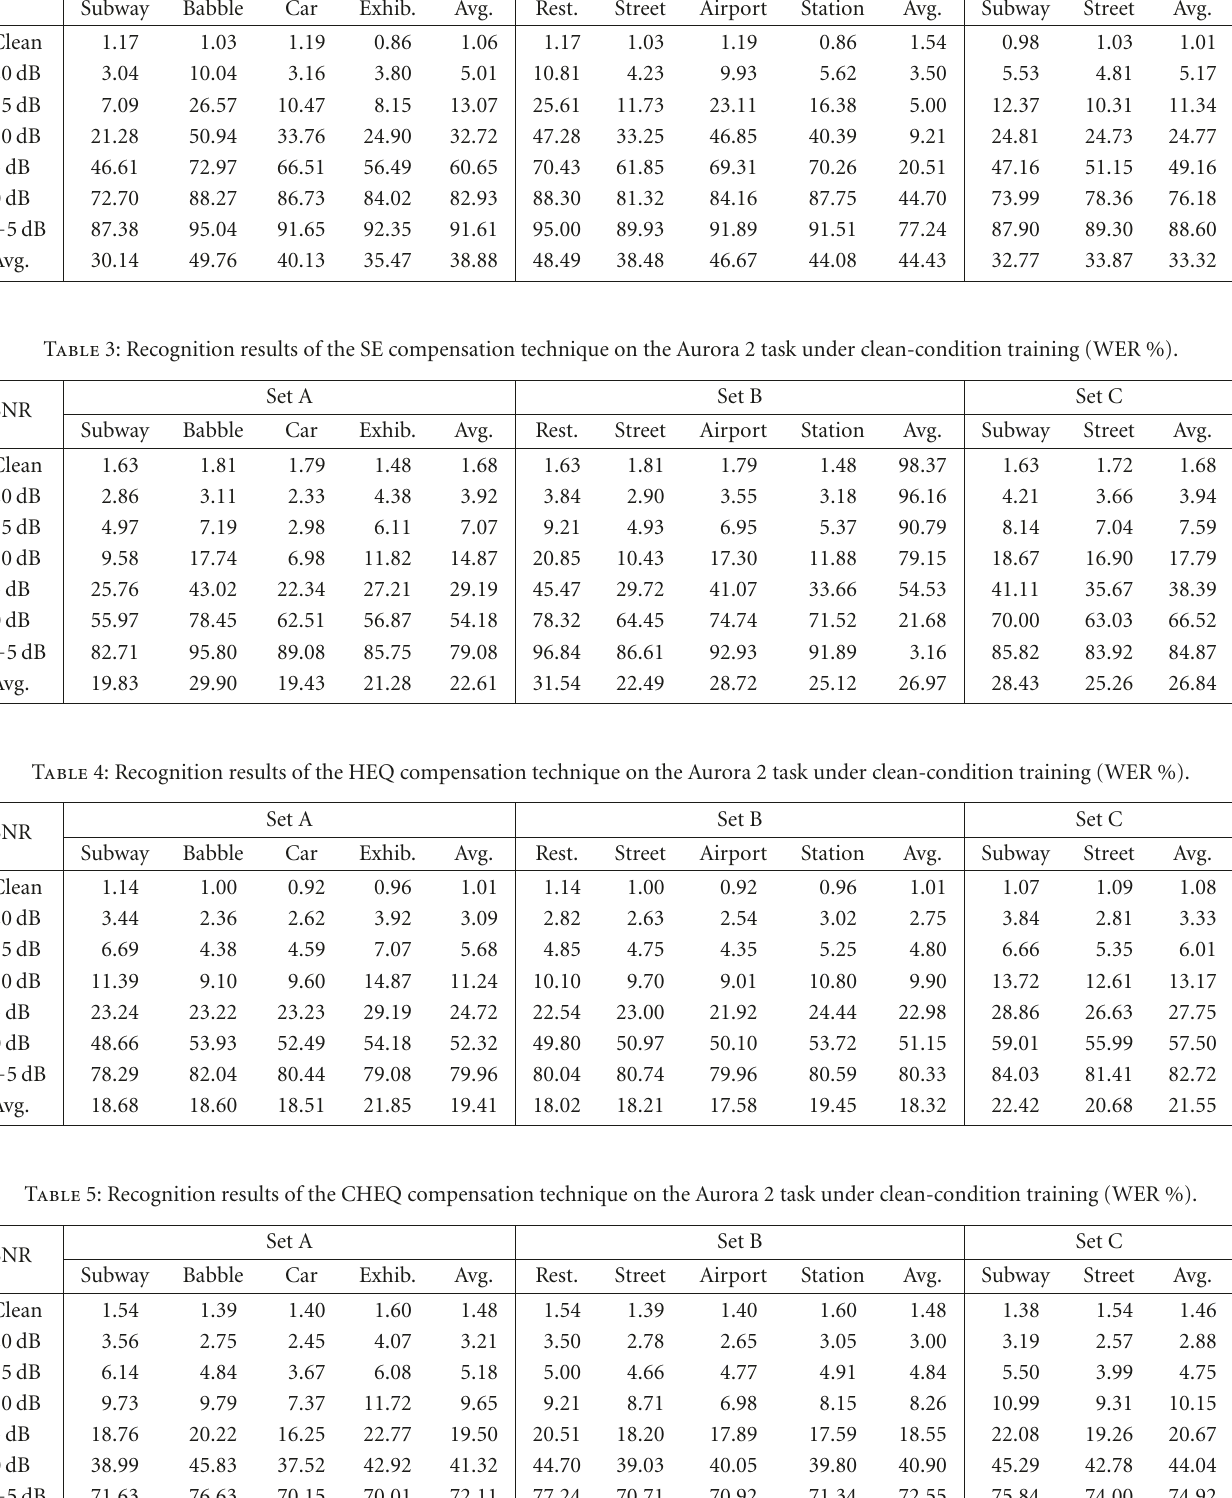
Table 2: Recognition results of the baseline feature (MFCC) on the Aurora2 task under clean-condition training (WER %). Set A Set B Set C SNR Subway Babble Car Exhib. Avg. Rest. Street Airport Station Avg. Subway Street Avg. Clean